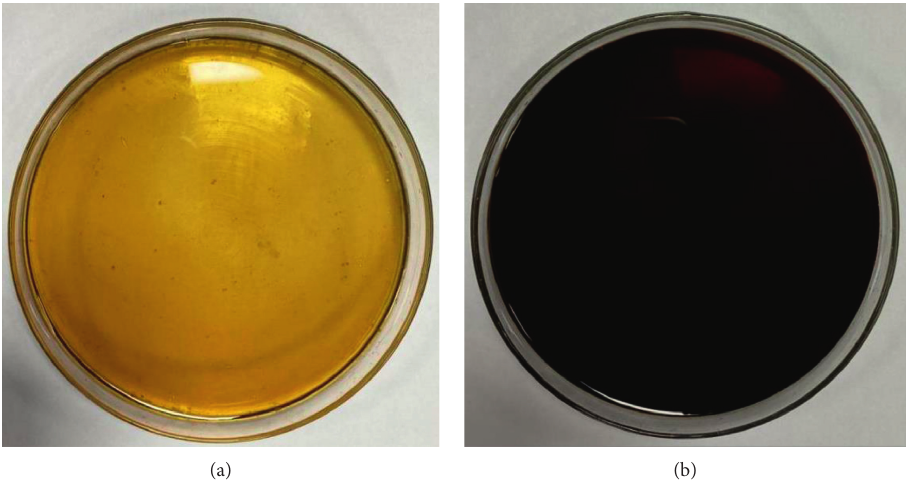
Figure 1: WMA agents. (a) Evotherm M1 (b) Retherm. High speed shearing at 3000 r/min for 2 min High speed shearing at 3000 r/min for 3 min And high speed shearing at 5000 r/min for 5 min And high speed shearing at 5000 r/min for 20 min Holding development in oven for 40 min HVA